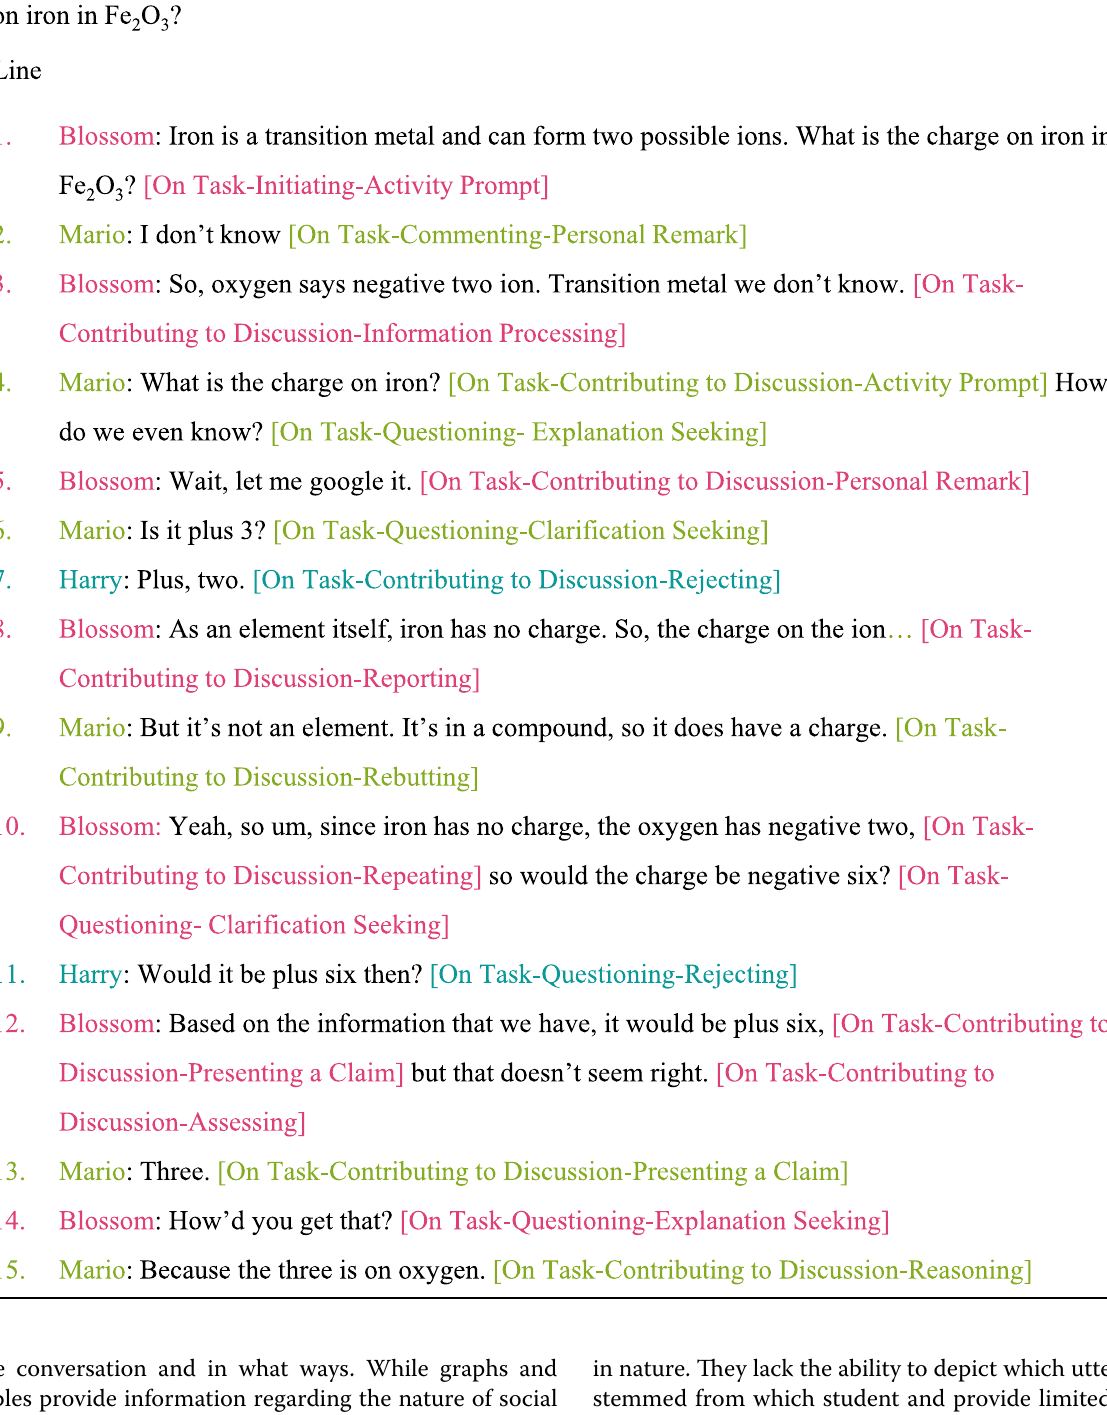
Table 4 Example Coding Excerpt. Coded excerpt transcript of students Mario, Blossom, and Harry as they worked through a POGIL prompt. Codes are written in the format as [Type of Interaction - Primary Intent – Nature of